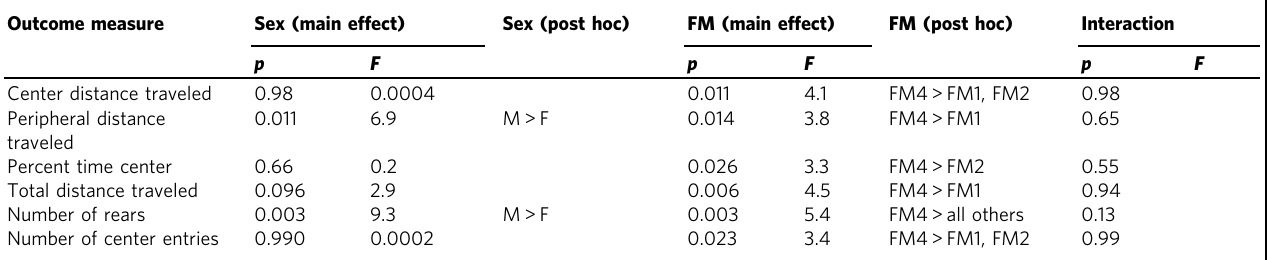
Table 2 Results of two-factor ANOVA of behavioral parameters during P4.